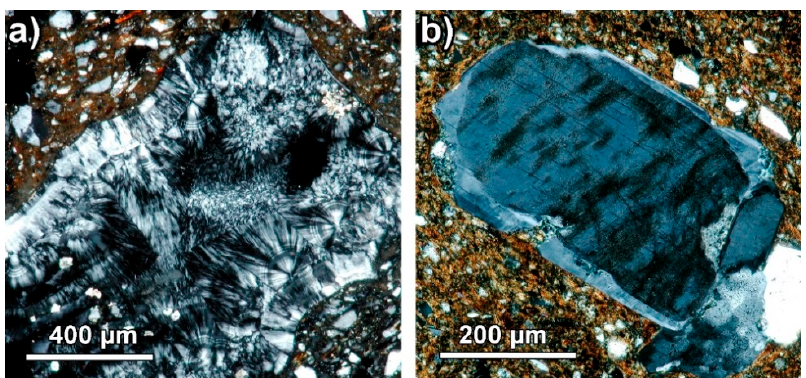
Figure 14. ( a ) XPL micrograph of a chalcedony inclusion found within the paste of shard depicted in Figure 8d. ( b ) XPL micrograph of a K-feldspar inclusion found within the paste of shard depicted in Figure 8e containing a clear authigenic overgrowth .